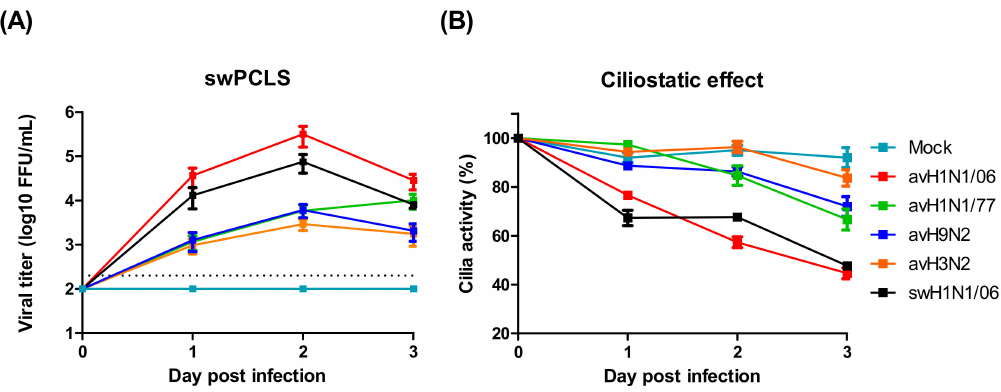
Figure 2. Avian influenza viruses infect swine lower respiratory tract. ( A ) Swine precision-cut lung slices (swPCLS) were infected by di ff erent avian IAV subtypes. The avH1N1 / 06 shows high infectivity in the swPCLS, while other avian IAVs contain low infectivity. The dashed lines indicate detection limits for the assay. ( B ) The cilia activities of the infected swPCLS. The cilia beating activity reduced after virus infection. The maximal detrimental e ff ect was observed in avH1N1 / 06 infected group with approximal 60% on day 3 post infection. The results were shown as means ±